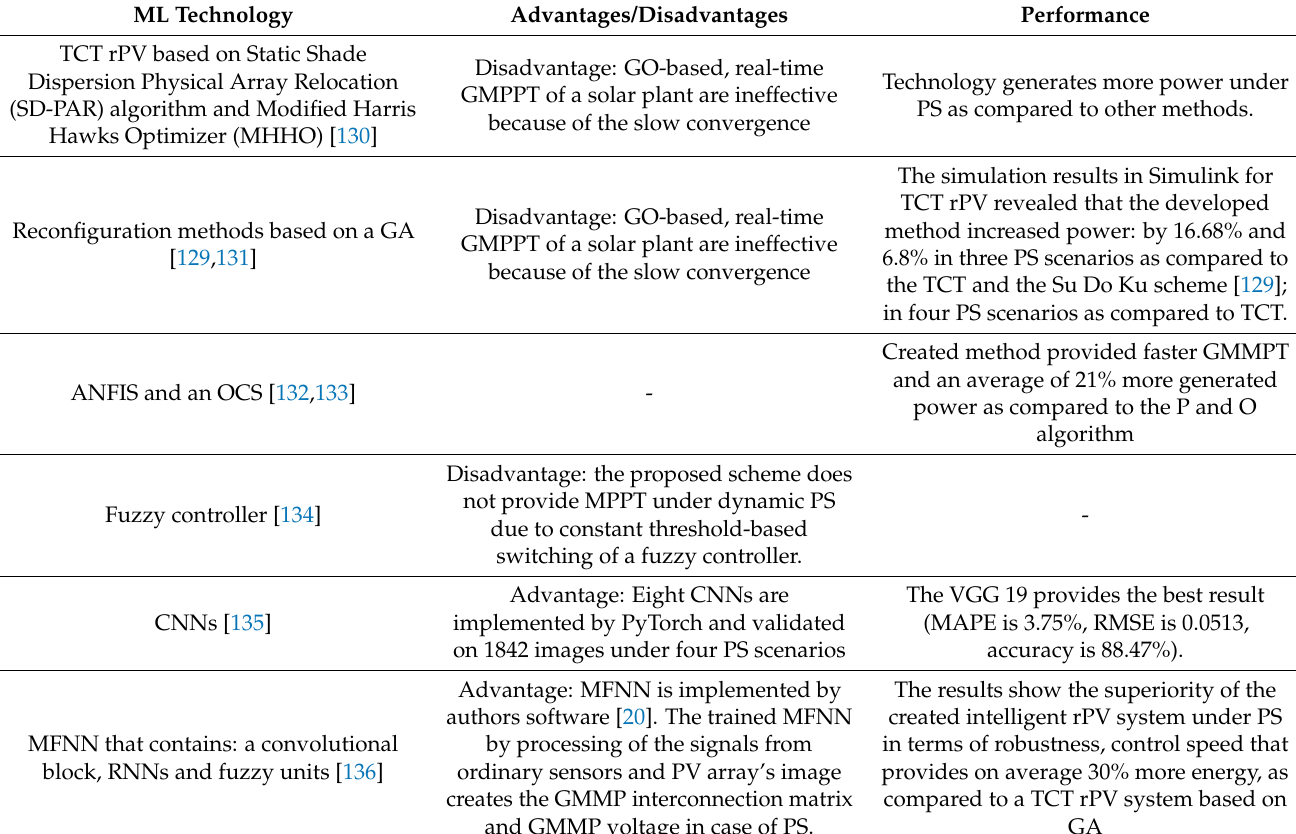
Table 12. Comparison of ML Technologies for Control of the Reconfigurable Solar Plants.